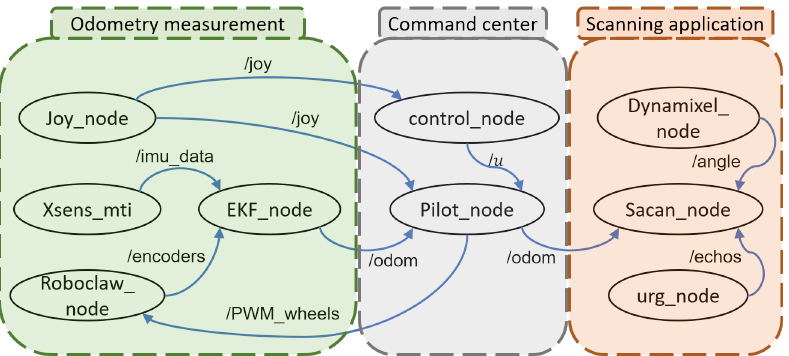
Figure 3. Computational software diagram in ROS nodes representation, from left to right the first, second, and third group of nodes. The nodes communicate with each other with messages, which are organized into specific categories called